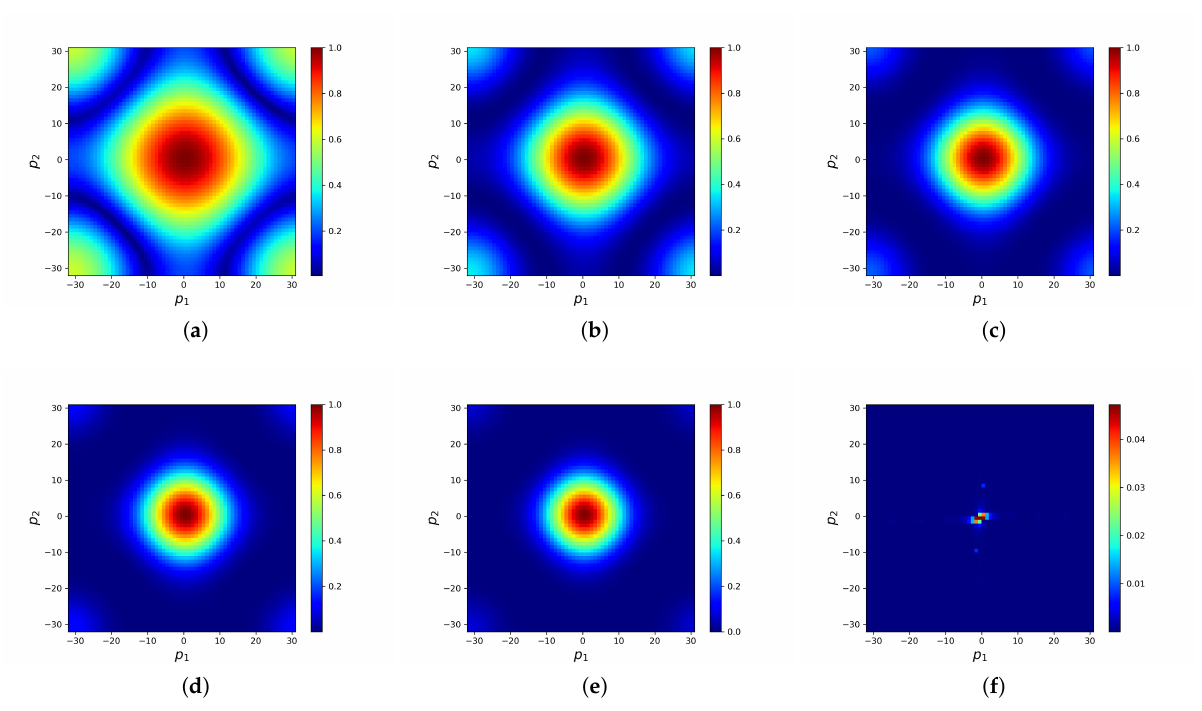
Figure 6. Distribution of convergence factor of five-times consecutive weighted Jacobi method. The last plot shows the distribution of errors learned by H in frequency space. ( a ) Convergence factor of one times weighted Jacobi ( ω = 4/5). ( b ) Two times. ( c ) Three times. ( d ) Four times. ( e ) Five times. ( f ) Learned ˆ e .